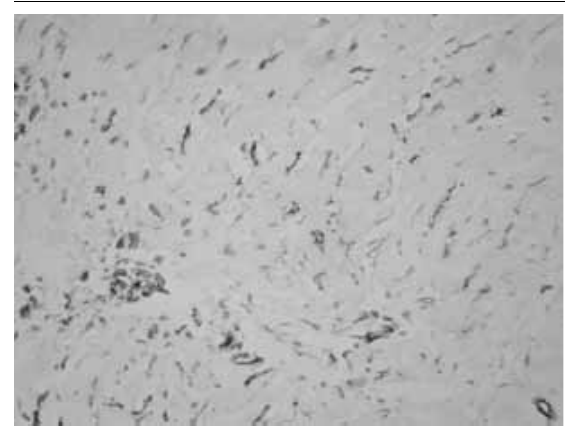
figurE 2 – Positive immunohistochemical expression of CD34 in neurofibromas (LSAB 200×) LSAB: labeled streptavidin-biotin